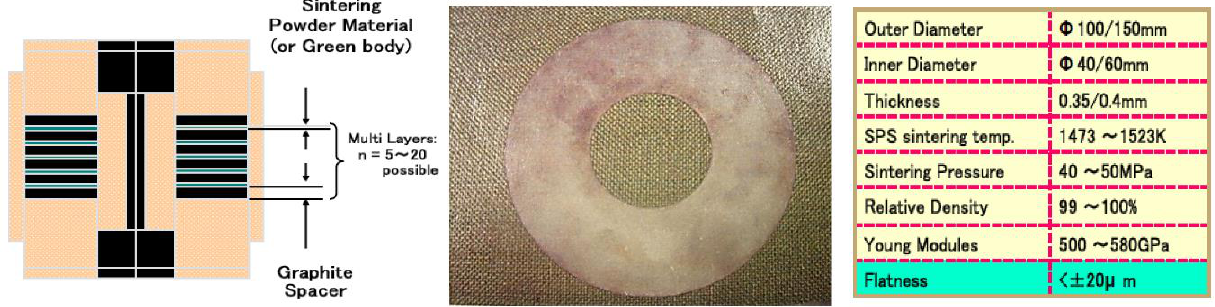
Figure 43. WC/Co sintered very thin plate with a diamond dicing blade.